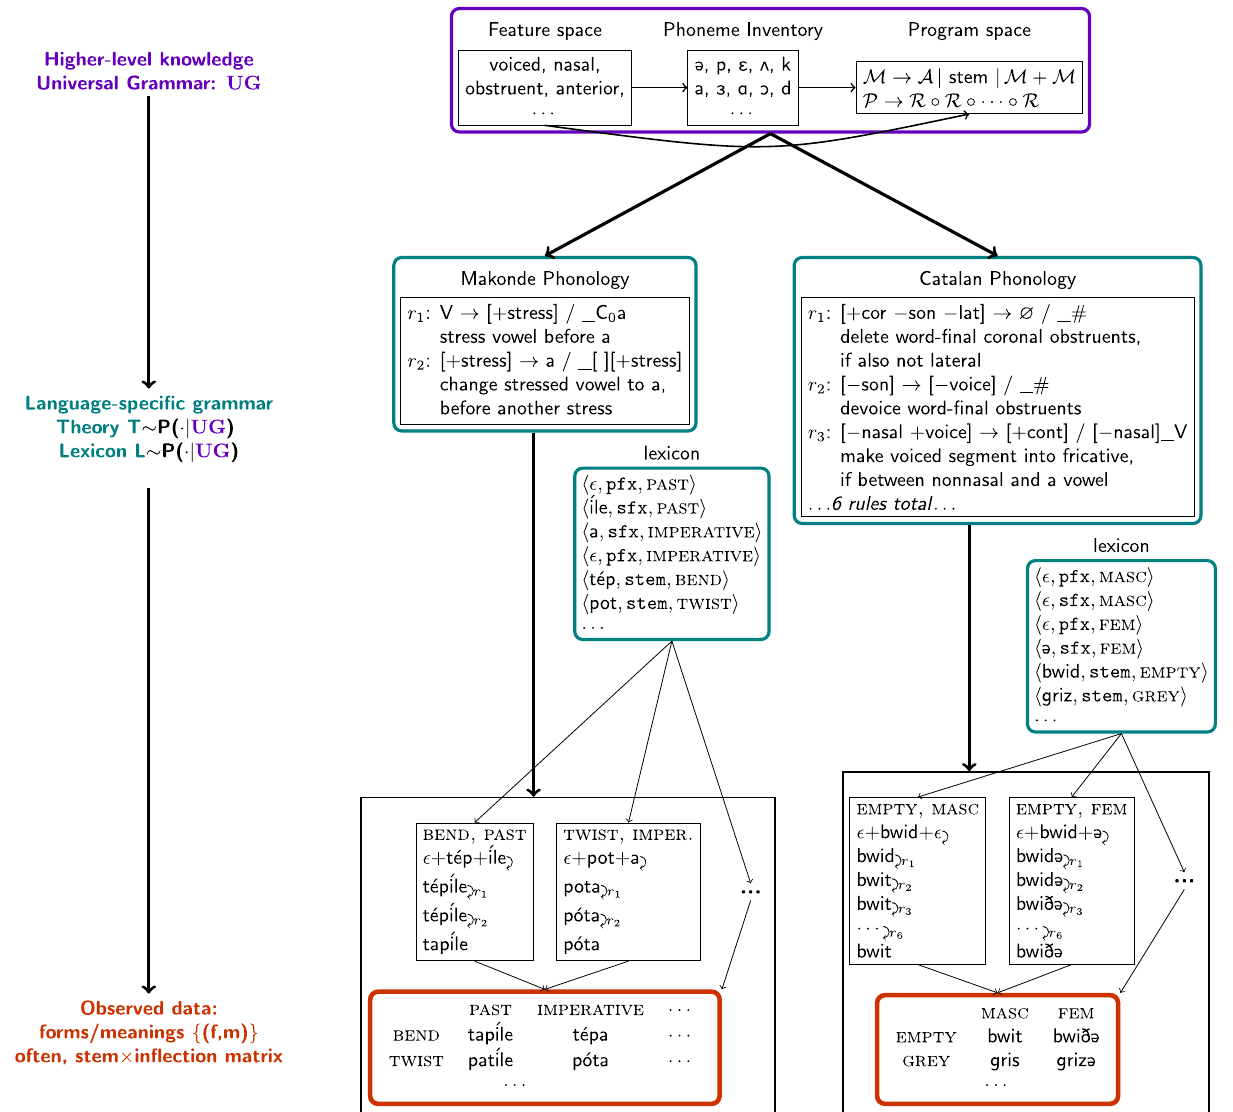
Fig.2|Thegenerativemodelunderlyingourapproach. Weinfergrammars(teal) for a range of languages, given only form/meaning pairs (orange) and a space of programs(purple).Form/meaningpairsaretypicallyarrangedinastem×in fl ection matrix.Forexample,thelowerrightmatrixentryforCatalanmeansweobservethe form/meaning pair ⟨ /griz ə /,[ stem :GREY; gender :FEM] ⟩ . Grammars include pho- nology, which transforms concatenations of stems and af fi xes into the